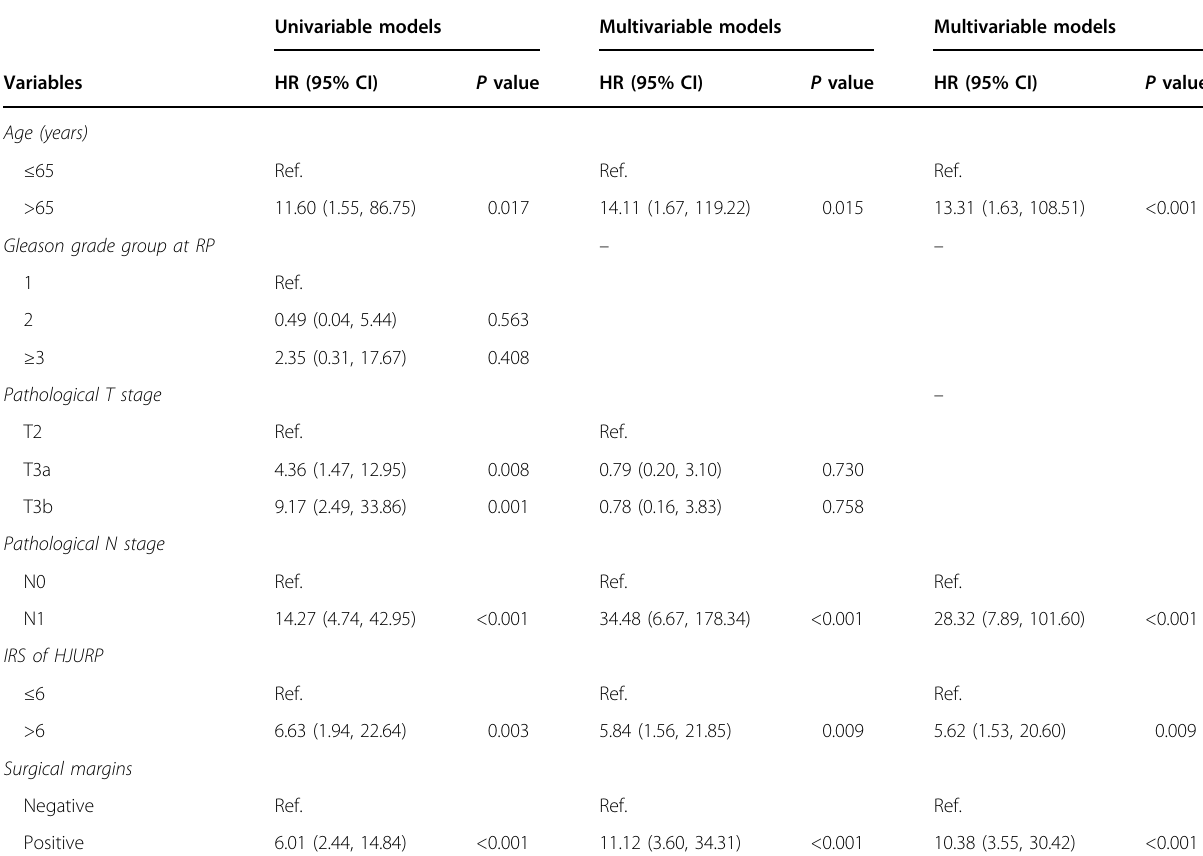
Table 1 Univariate and multivariate Cox regression analyses for overall survival in PCa patients enrolled in tissue